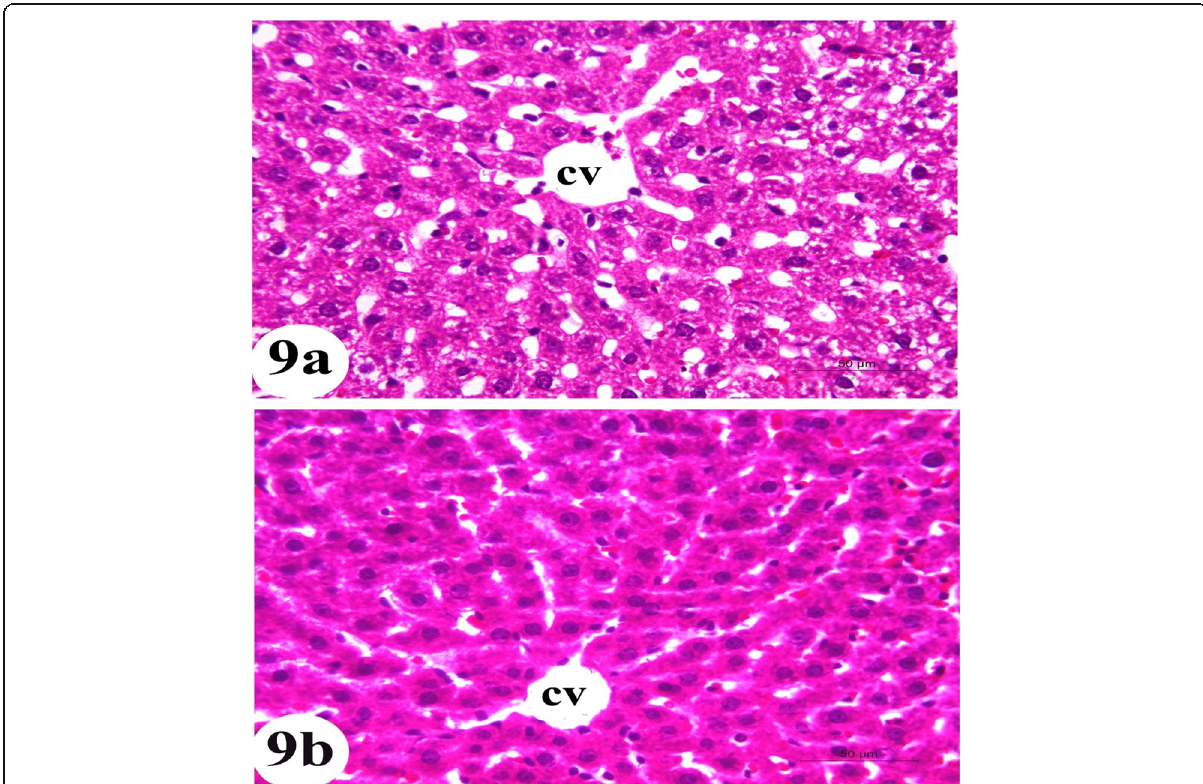
Fig. 9 Photomicrographs of sections of liver of treated rats stained with H&E a with LCT plus ginseng 100 mg/kg b. wt./day showing relative recovery except vacuolar degeneration of hepatocytes and dilated sinusoids (scale bar = 50 μ m). b With LCT plus ginseng 200 mg/kg b. wt./day group showing approximate regain of normal appearance of hepatocytes and central vein (CV) (scale bar = 50 μ